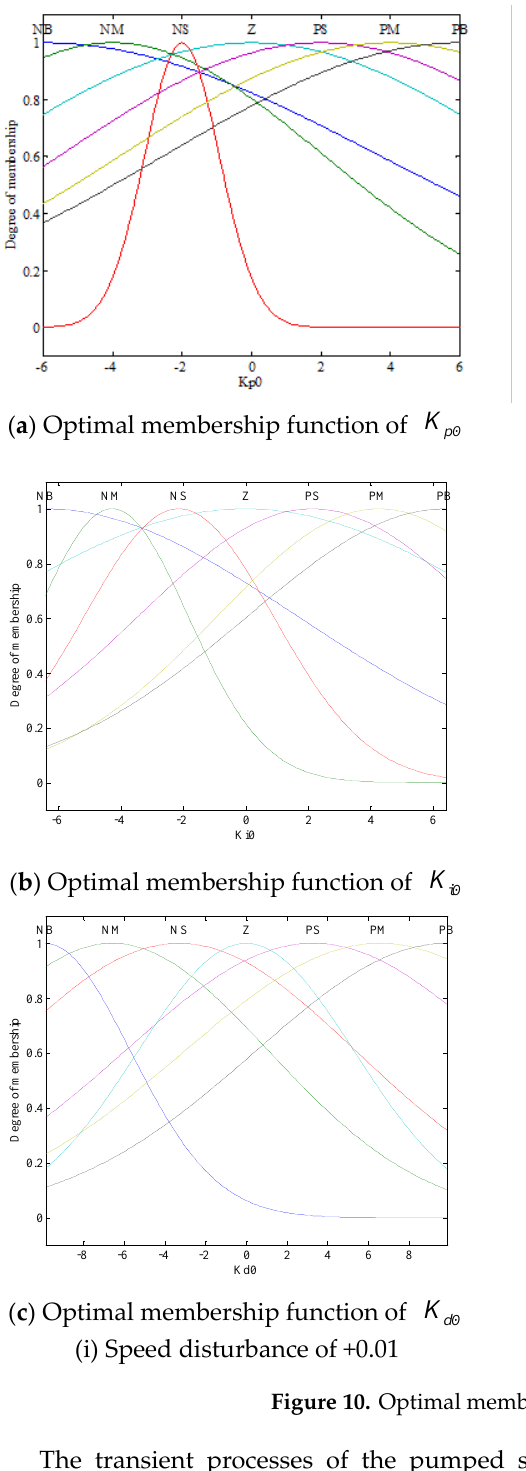
( b ) Speed disturbance of −0.01